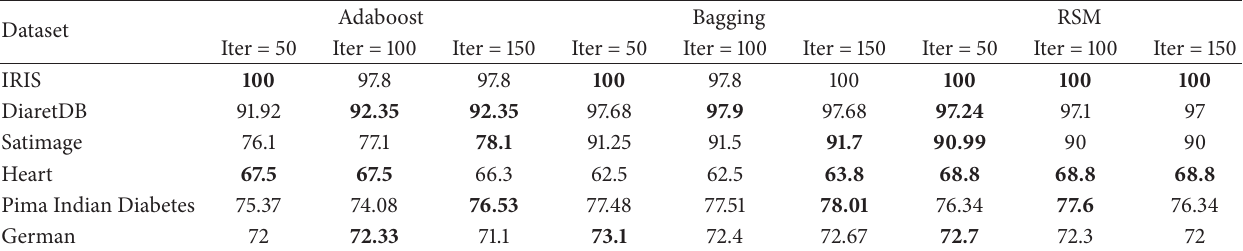
Table 4: Classification accuracies of competitors using different number of training iterations.